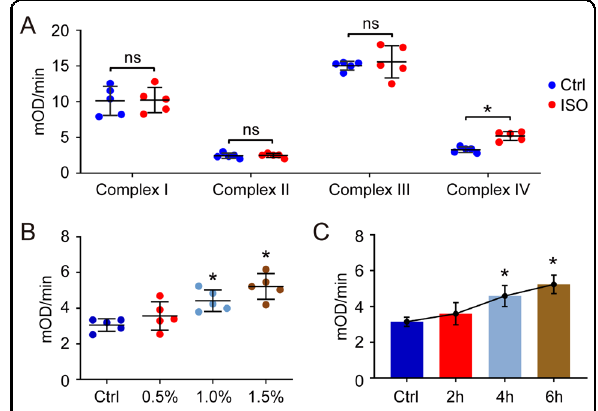
Fig. 3 Analysis of the activity of Complex I – IV in mitochondrial ETC. After iso fl urane exposure (ISO, 1.5%) for 6 h, the hippocampus was isolated for the analysis ( A ). The effect of iso fl urane exposure on the activity of cytochrome c oxidase/Complex IV in mitochondrial ETC was also evaluated in does-dependent assay ( B ) and time-dependent assay ( C ). In A , * p value < 0.05 compared between two groups. ns: p value > 0.05 compared between two groups. In B , C , * p value < 0.05 compared with the Ctrl